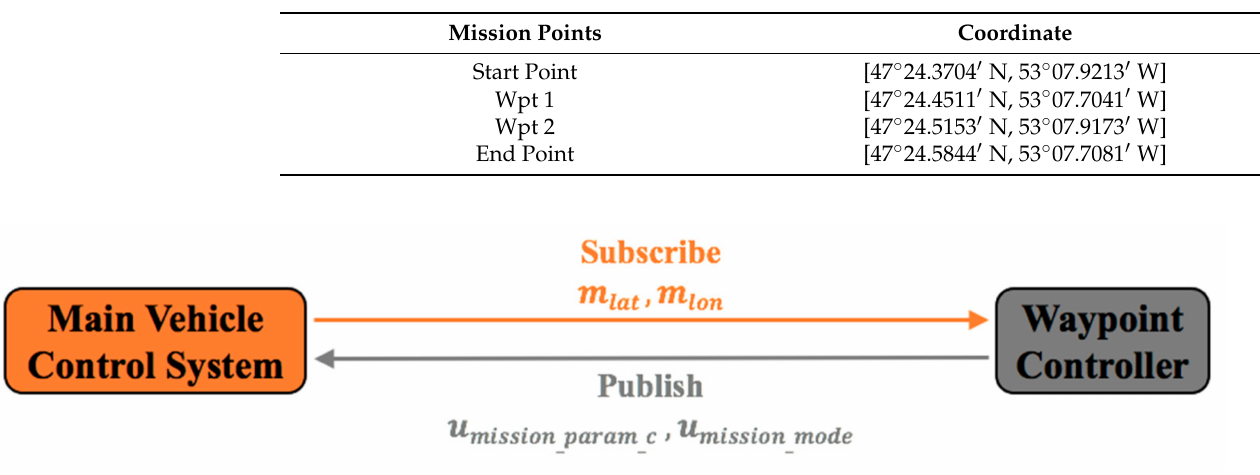
Table 5. Waypoint list for the adaptive waypoint behavior of the glider.